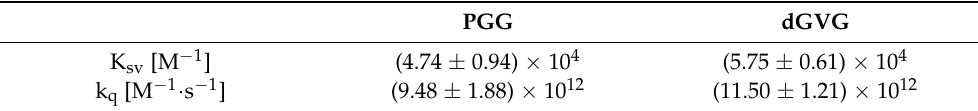
Table 4. Calculated Stern–Volmer (Ksv) and bimolecular quenching (k q ) constants for PGG and dGVG interaction with S. aureus membrane proteins.